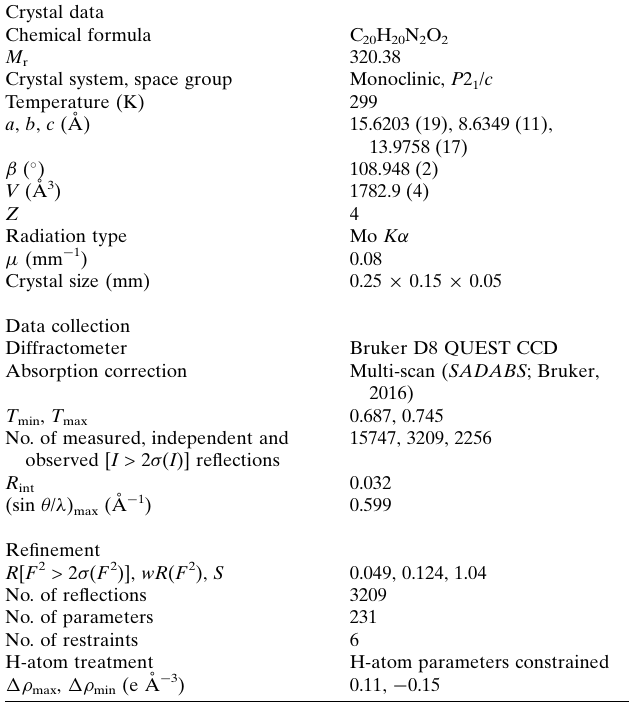
Table 2 Experimental details. Crystal data Chemical formula